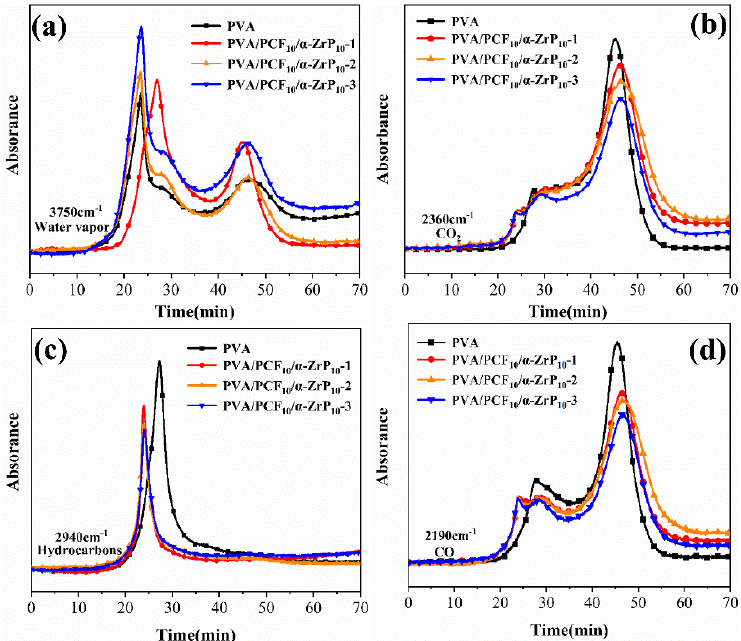
Figure 12. Absorbances of pyrolysis products of PVA and PVA/PCF 10 / α -ZrP 10 -x vs. time: ( a ) water vapor, ( b ) CO 2 , ( c ) hydrocarbons, and ( d ) CO.